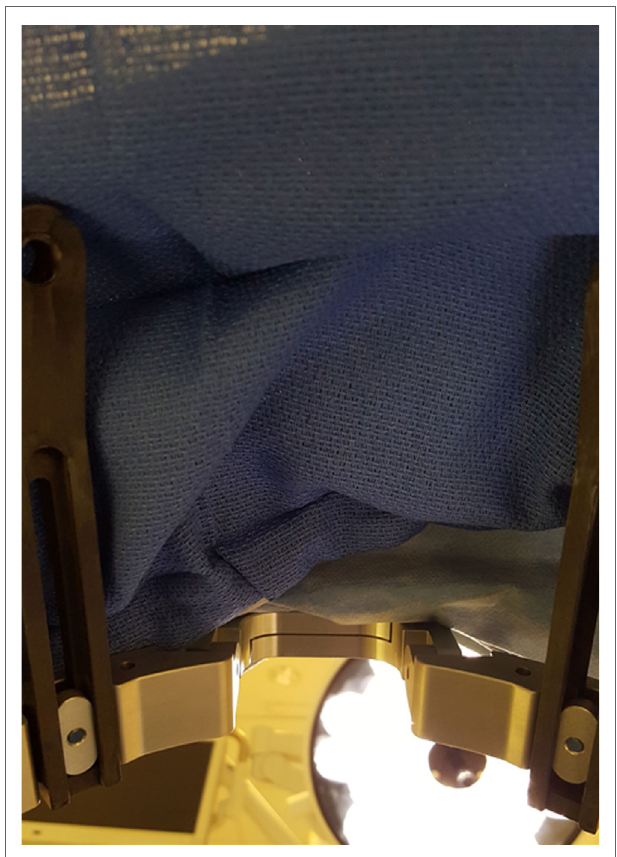
FIGURe 6 | simulated patient perspective, after sterile draping, during the DBs procedure . The patient may experience this viewpoint for 4–6 h, as the surgery is being